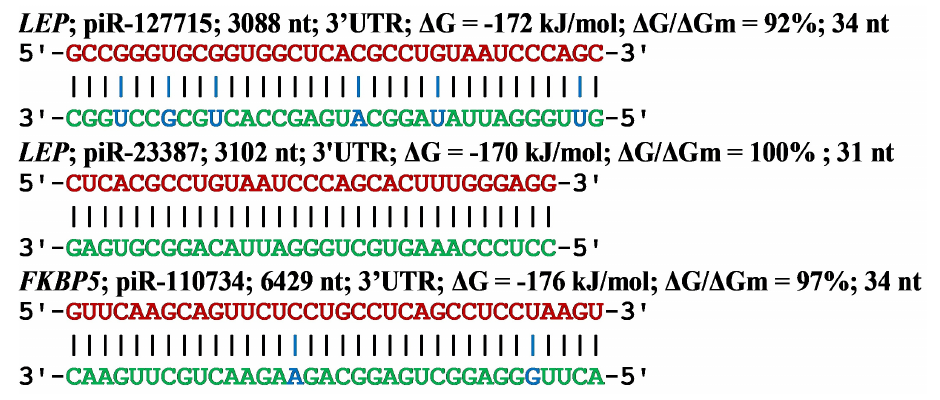
Figure 1. Nucleotide sequences of piRNA BSs in the 3 ′ UTR of mRNA and nucleotide sequences of piRNAs. Note: The nucleotides of piRNAs forming canonical and non-canonical pairs with mRNA are highlighted in green and blue, respectively.